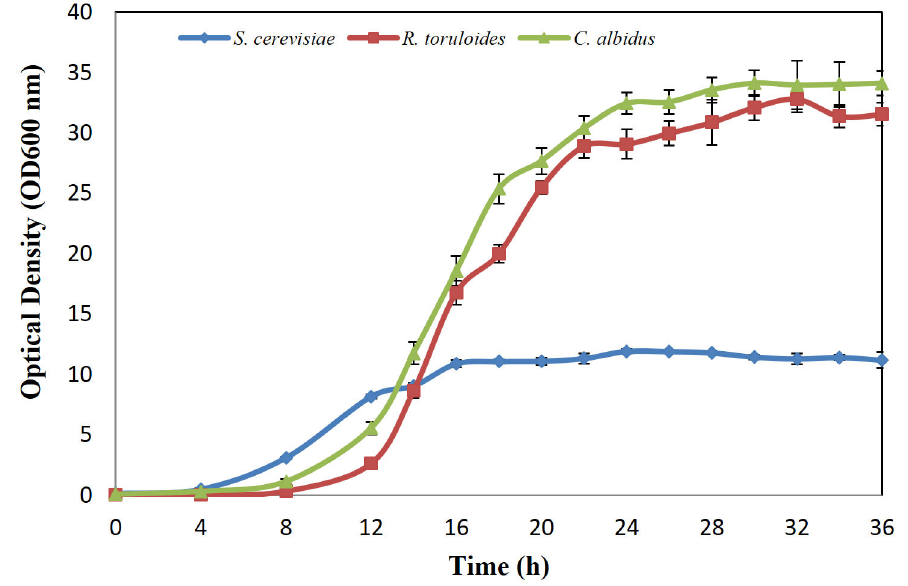
Figure 2. Growth curve of S. cerevisiae , R. toruloides and C. albidus in YEPD medium. Data from three replications were analyzed to calculate means and standard